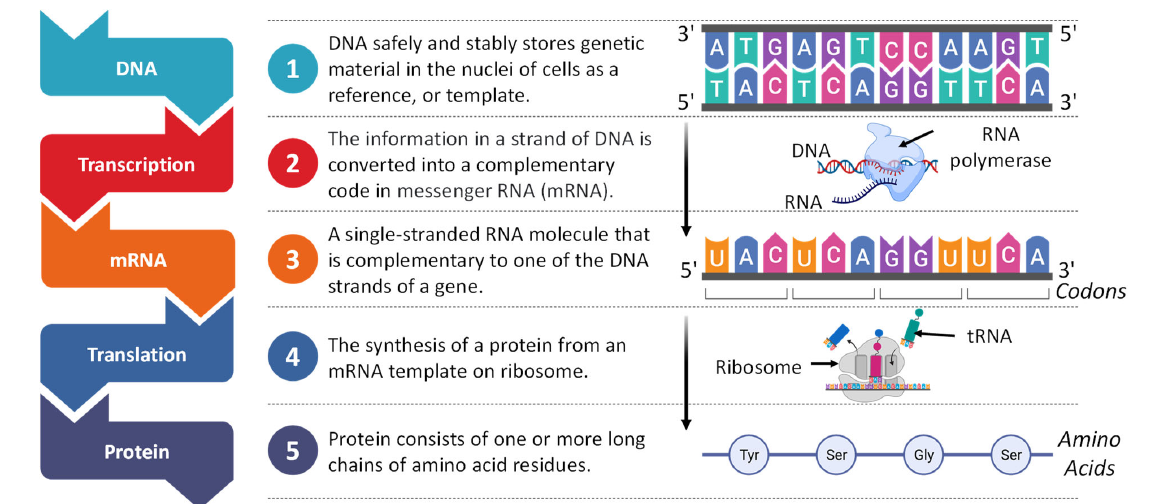
Figure 6. Main stages of protein synthesis.